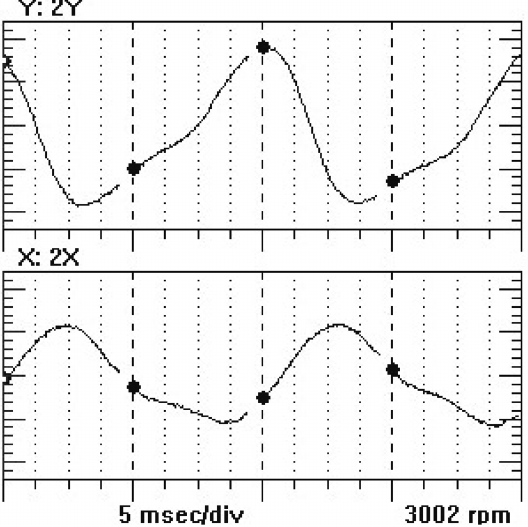
Fig. 15. Vibration signals measured on the support #2 (XY probes) during an event of abnormal subsynchronous vibration levels of the HP-IP turbine.